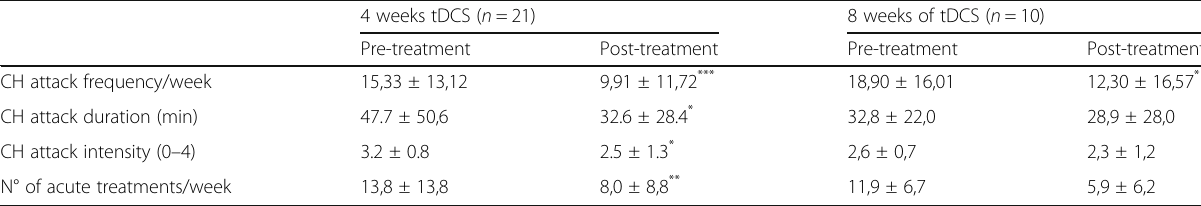
Table 2 Clinical outcome measures: per protocol analysis